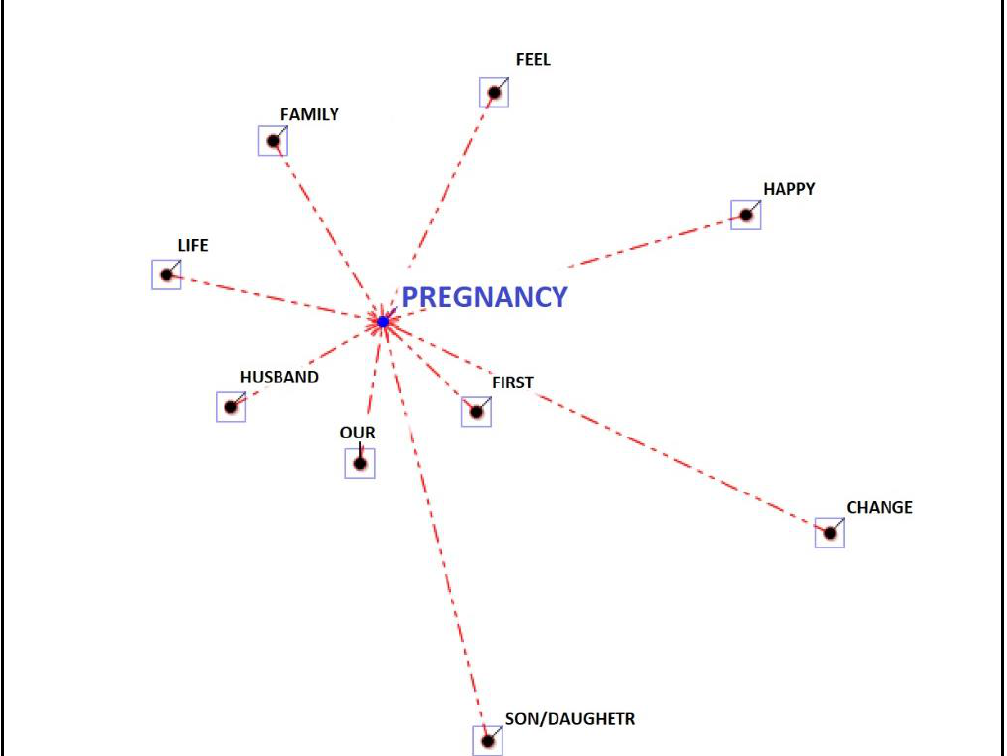
Figure 3. Associations to the topic “change”.